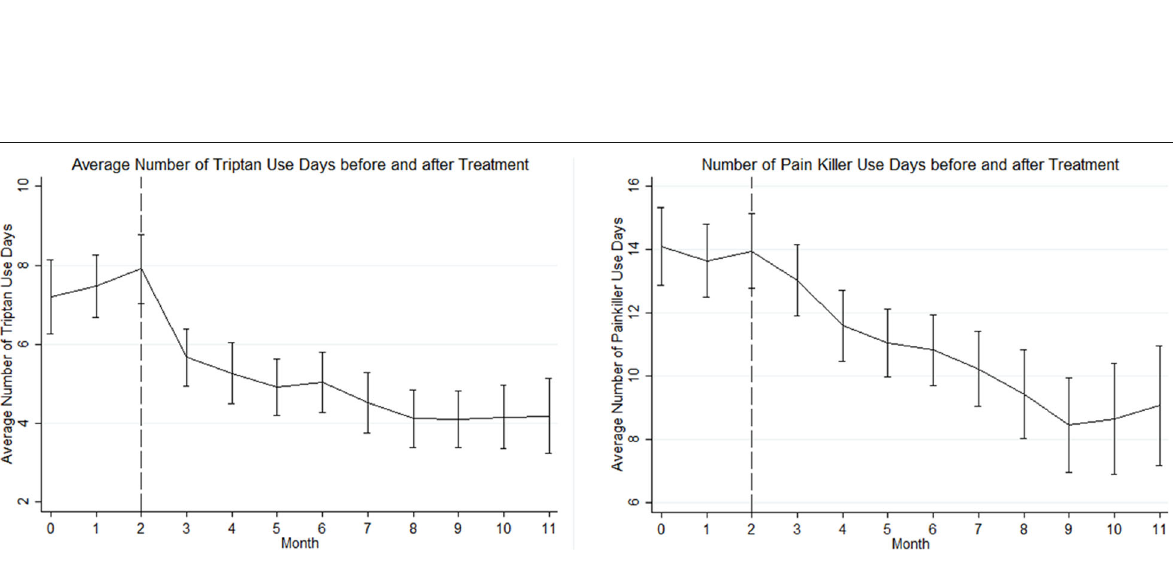
Fig. 4 Graphs showing mean number of days requiring triptans, and requiring painkillers (simple or opiate analgesics), before and after commencing erenumab. Three months of baseline data (month 0, 1, 2) is followed by 9 months of post-treatment data (month 3 – 11). Error bars represent standard error of the